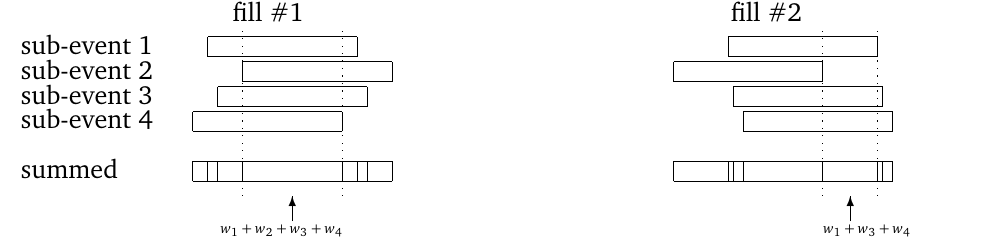
Figure 2: A pictorial view of how the sub-windows are constructed for a one dimen- sional